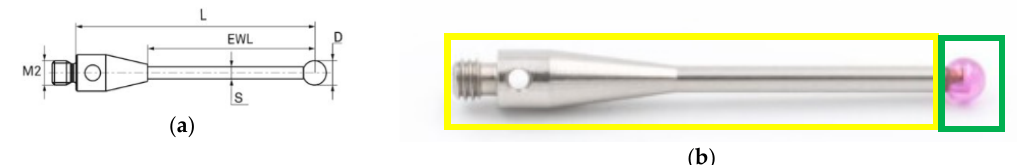
Figure 2. Probe configuration and dimensions: ( a ) Probe characteristics; ( b ) Characteristic marked with yellow are inactive and with green are active. “Pitch diameter measurements of internal threads are more complicated than external threads [2] due to construction of internal thread which does not allow easy probing like external threads”.